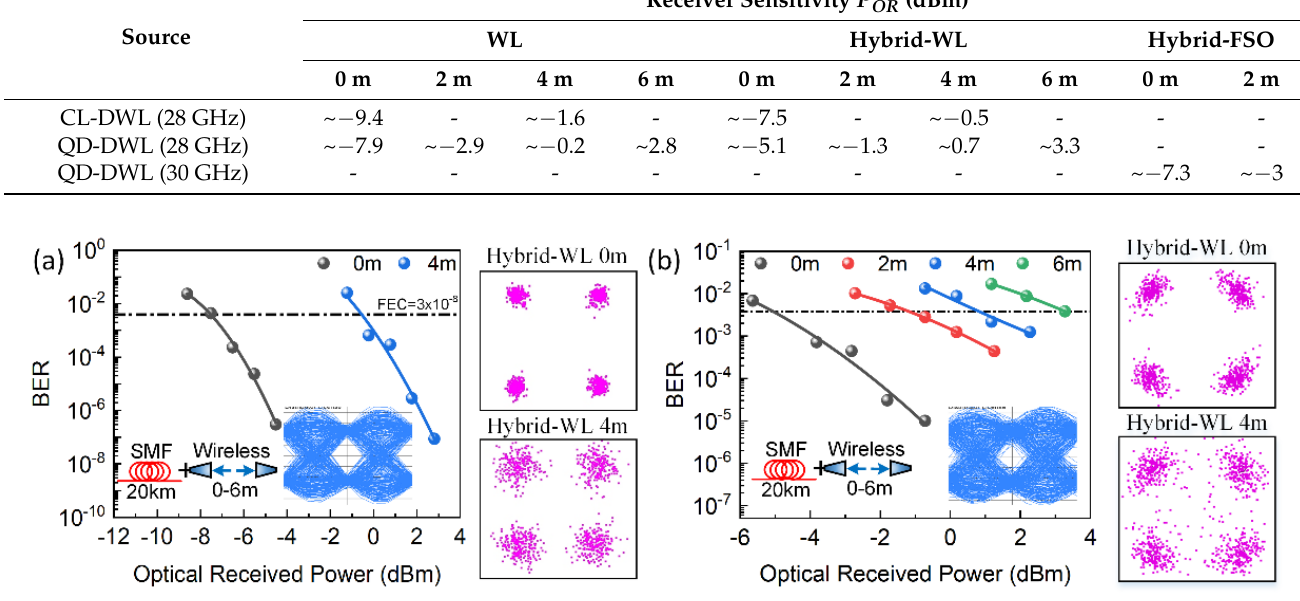
Figure 4. Bit error rate (BER) versus optical received power of the commercial laser and dual-wavelength laser (CL-DWL) source at 28 GHz ( a ) and the QD-DWL source at 28 GHz ( b ) for the WL channel with various link lengths. The respective insets show the received QPSK constellation at a ~0 dBm received optical power for the 0-m (top) and 4-m (bottom) WL link lengths.